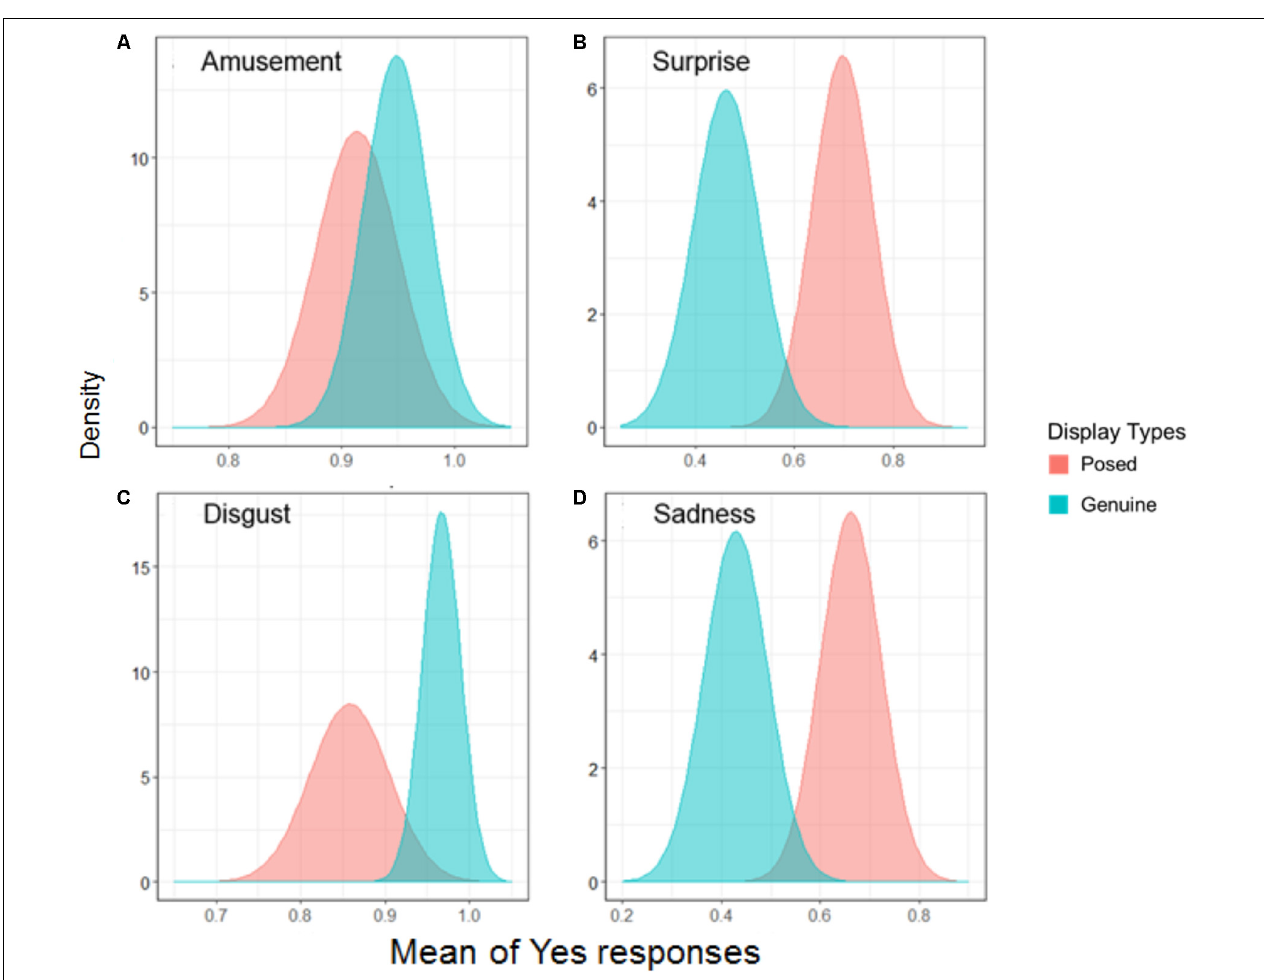
FIGURE 4 | The mean of Yes responses on the show condition across each emotion. The distance between the two distributions can be interpreted as the discriminability of facial displays. Comparisons are shown for each specific emotion: (A) amusement, (B) surprise, (C) disgust, and (D) sadness.